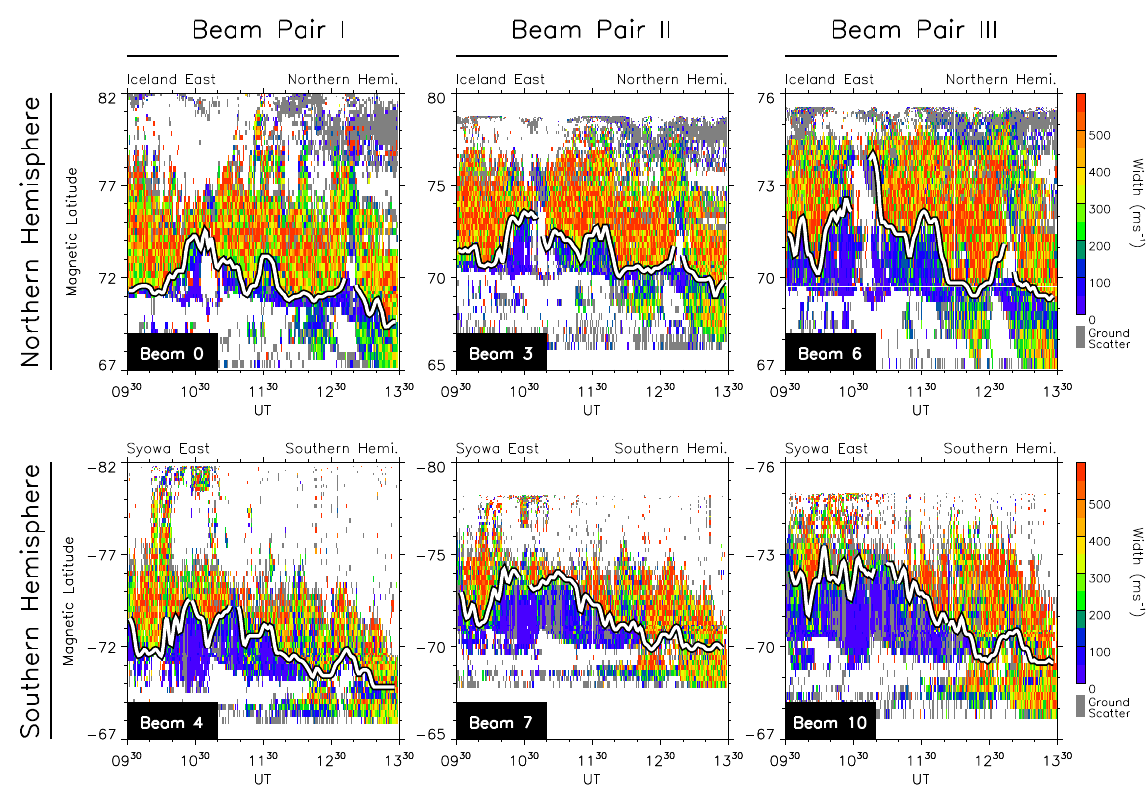
Fig. 2. The latitude versus time spectral width plot for the beams of each conjugate beam pair during the period of the present study, from 09:30UT to 13:30UT, 10 October 1999 (top panels) for beam 0, 3 and 6 of Iceland East in the Northern Hemisphere, (bottom panels) for beam 4, 7 and 10 of Syowa East in the Southern Hemisphere. A white line in each panel presents the spectral width boundary estimated using the algorithm described in the